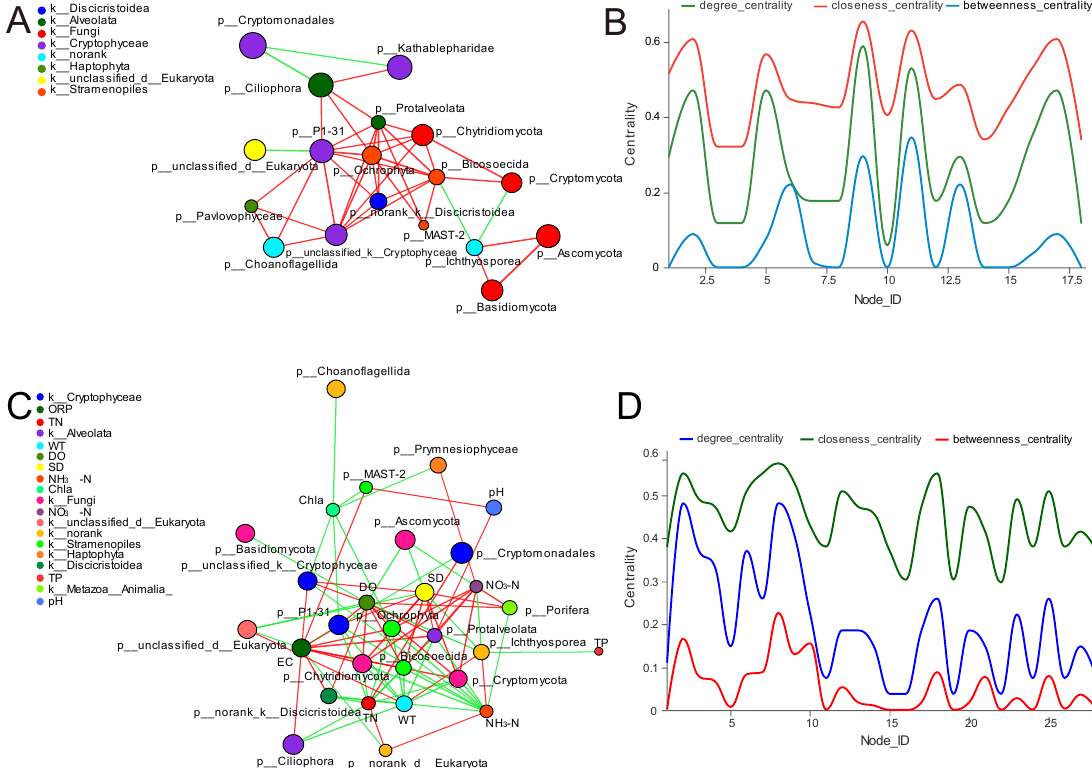
Figure 9. Single- and two-factor network analysis of planktonic eukaryotes. Note: Single-factor network analysis ( A ) and network center coe ffi cient distribution diagram ( B ); two-factor network analysis ( C ) and network center coe ffi cient distribution diagram ( D ). Taxa with p < 0.05 are shown by default. The size of the nodes in the figure indicates the abundance of taxa, and di ff erent colors indicate di ff erent taxa. The color of the line indicates the type of correlation; red indicates a positive correlation, and green indicates a negative correlation. The thickness of the line indicates the size of the correlation coe ffi cient; the thicker the line is, the higher the correlation between taxa. The more lines there are, the closer the connection between the nodes